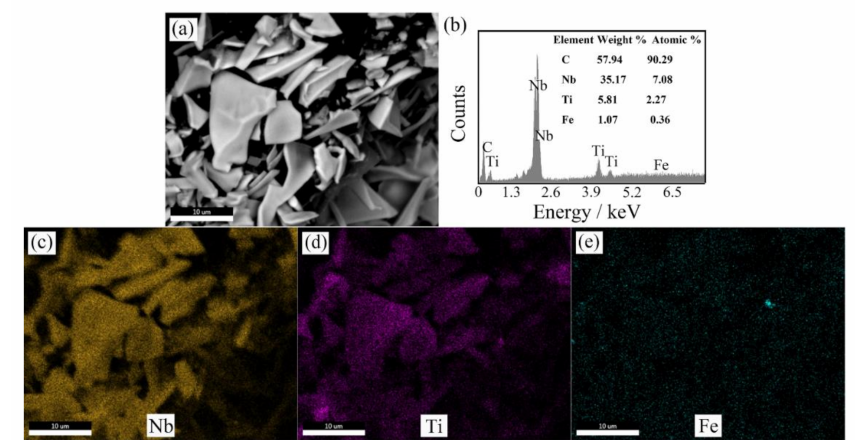
Figure 5. SEM mapping image of precipitate in sample D; ( a ) micromorphology; ( b ) the correspond- ing EDS spectra in ( a ); ( c – e ) the microstructural distribution of Nb (yellow); Ti (purple); Fe(blue); respectively.